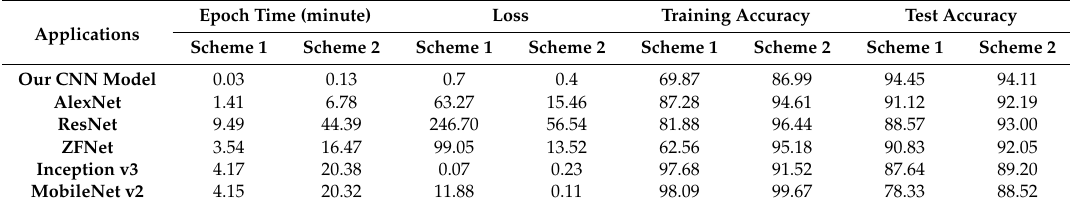
Table 6. The performance of CNN application models trained on RSSI datasets and the assessment of four